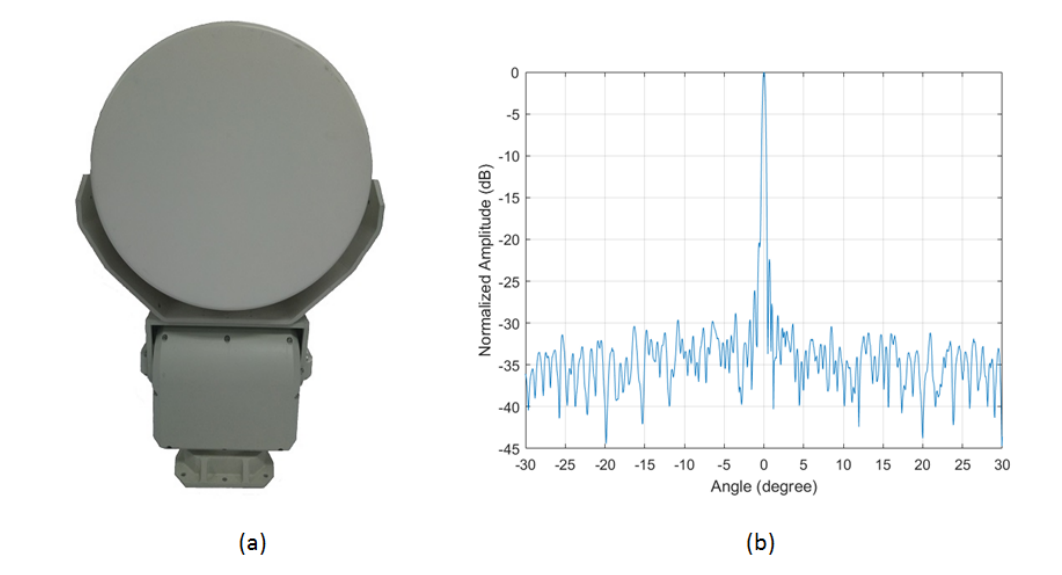
Figure 4. Some details of FOD millimeter-wave radar: ( a ) radar appearance; and ( b ) measured antenna azimuth radiation pattern at 93